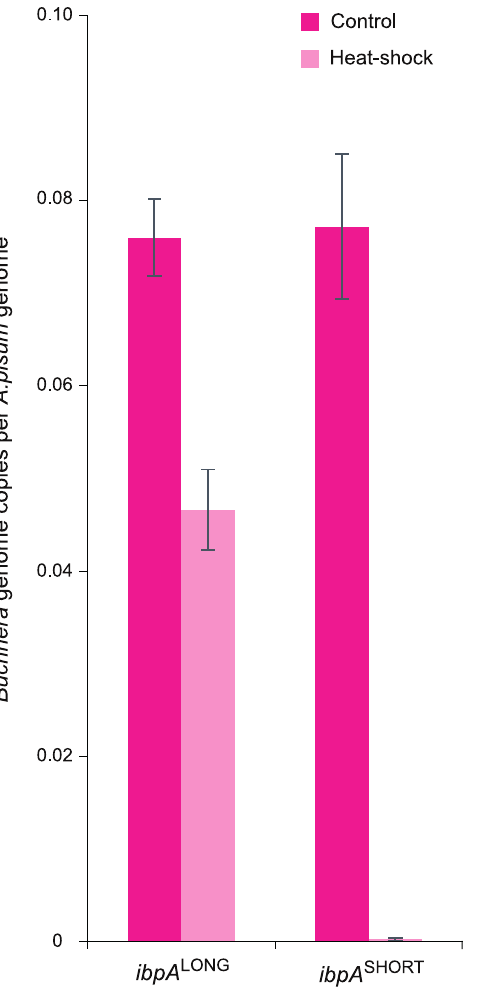
Figure 6. Effect of Heat Stress on Buchnera Densities in Aphids Bearing Buchnera with Different ibpA Promoter Alleles Estimates of Buchnera and aphid genome numbers are based on qPCR assays of genomic DNA determining numbers of copies of single-copy Buchnera genes relative to a single-copy aphid gene. Heat treatment was 4 h at 35 8 C on day 2 following birth, and measures were taken within 24 h of attaining adulthood. Bars show means 6 standard errors.